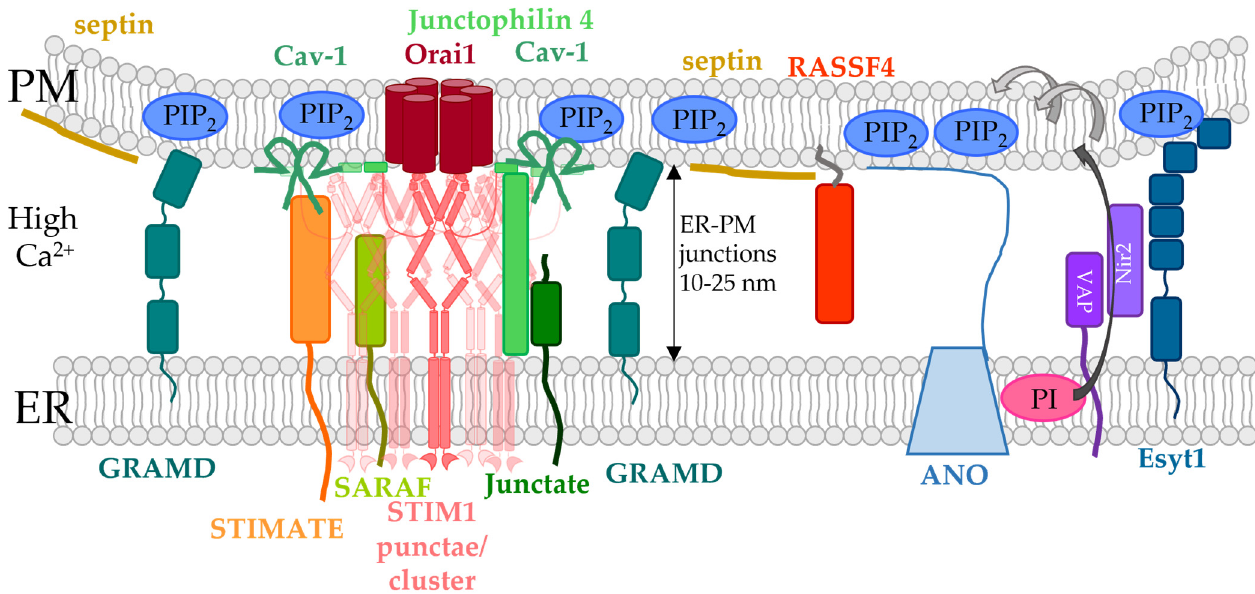
Figure 5. Complex interplay of ER-PM proteins and lipids with the STIM1/Orai1 channel. GRAMD, Ano8 and E-Syt proteins modulate the ER-PM contact site to facilitate the interplay of STIM1 and Orai1 in an indirect manner. STIMATE, junctate, and junctophilin 4, together with PIP 2 , directly interact with STIM1 to support its oligomerization, association near the PM, and coupling with Orai1. SARAF contributes to efficient restorage of the closed state of STIM1 through direct interaction. RASSF4 and septins modulate PIP 2 levels in the PM and are thus indirectly involved in STIM1 activation. Cav-1 is thought to move Orai1 into cholesterol-rich regions.